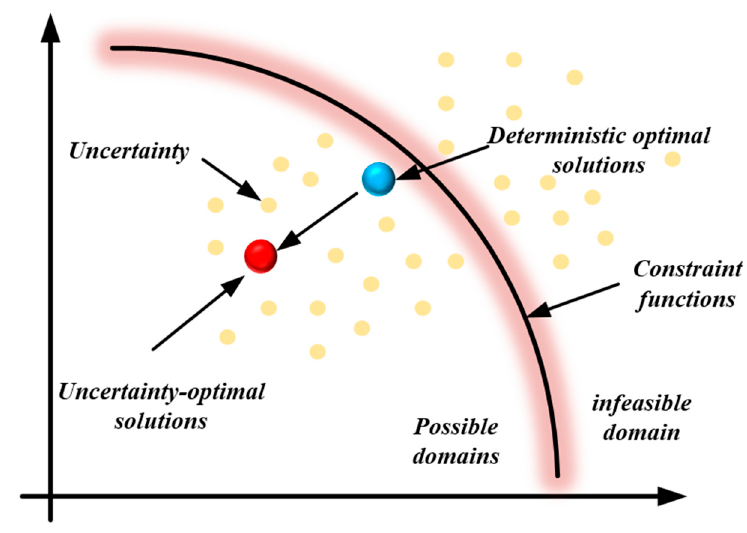
Figure 1. Robustness of constraints.